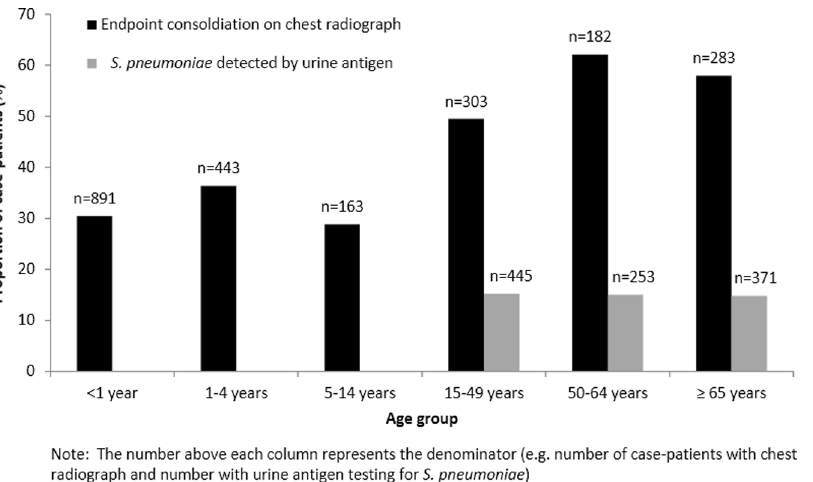
Figure 2. Streptococcuspneumoniae and endpoint consolidation by age group. Percent of case-patients with endpoint consolidation on chest radiograph and Streptococcus pneumoniae detected by urine antigen, by age group.